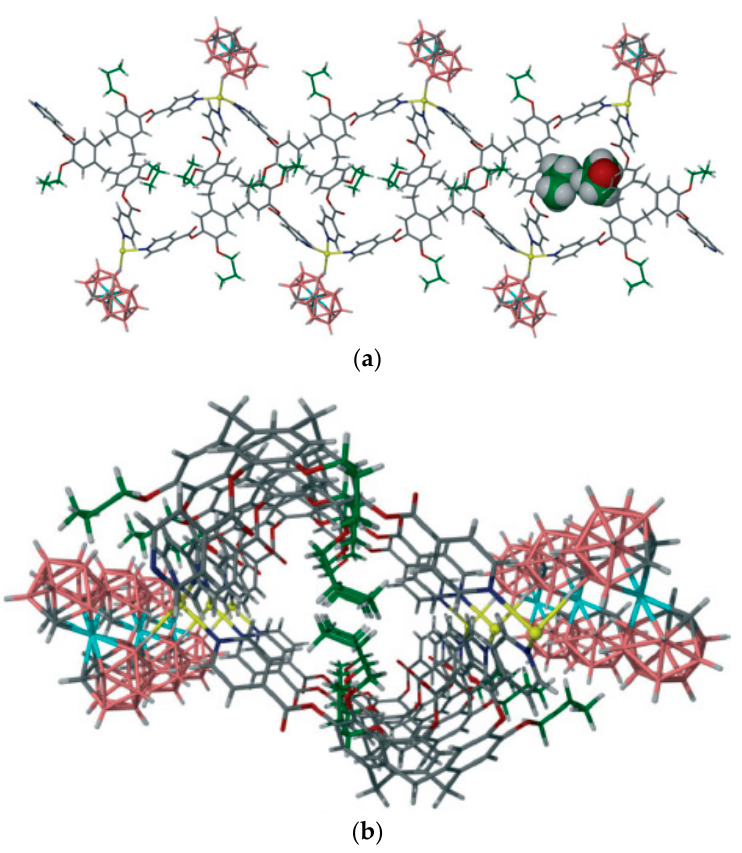
Figure 119. Fragment of X-ray crystal structure ( a ) and crystal packing ( b ) in {[Ag(tris(isonic)CTG-Pr)[3,3’-Co(1,2-C 2 B 9 H 11 ) 2 ]]·2.5(DMF)·H 2 O} n . Reproduced from reference [125] with permission from The Royal Society of Chemistry.